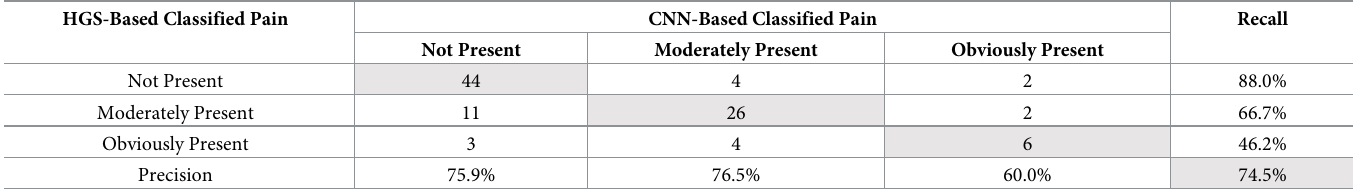
Table 6. Confusion matrix between the data classified by the CNN-based model and HGS for the mouth and nostrils images. HGS-Based Classified Pain